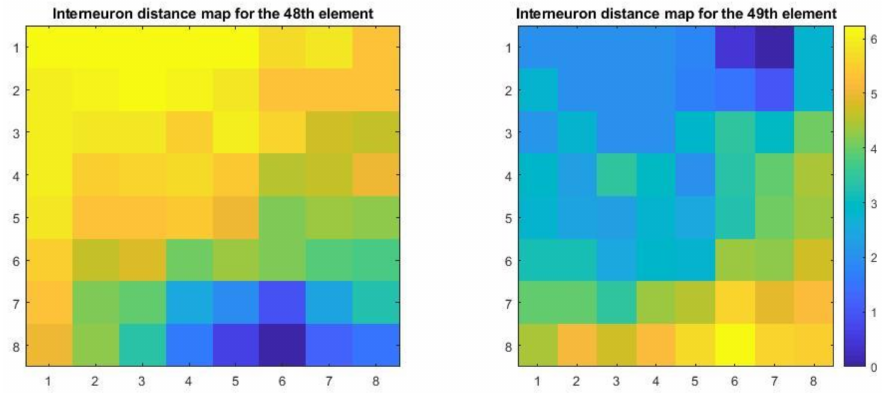
Figure 7. Distance maps for network elements 48 and